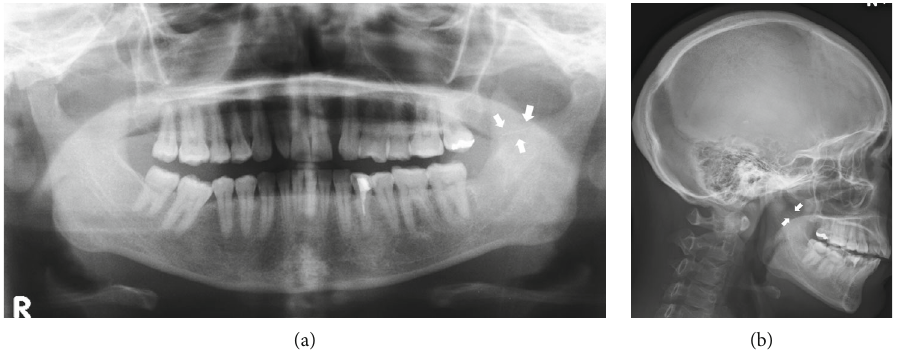
Figure 1: (a) Panoramic X-ray performed at the fi rst visit. The broken injection needle can be seen at the base of the left coronoid process (arrows). (b) Lateral cephalometric X-ray. The broken injection needle can be seen at the base of the left coronoid process (arrows).